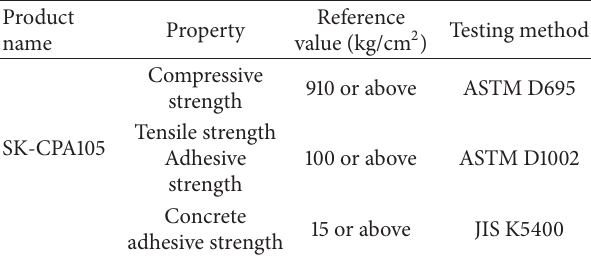
Table 3: The characteristics and properties of adhesives for aramid fiber sheets.